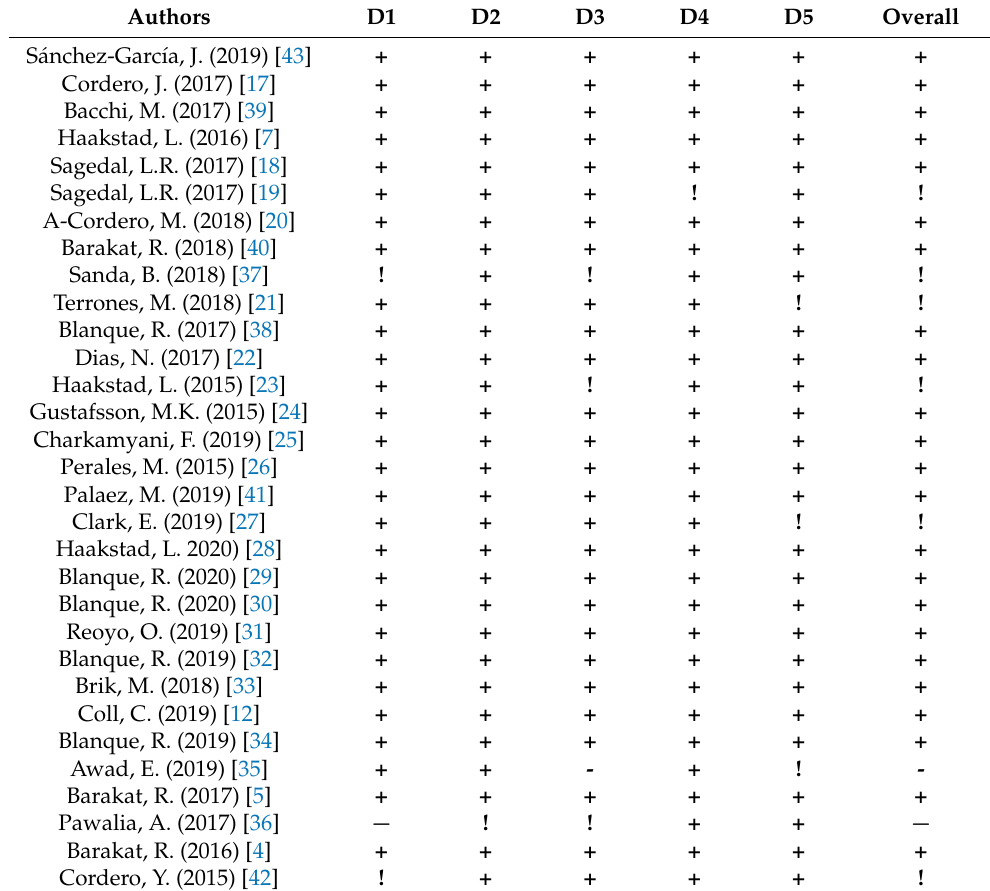
Table 1. Quality assessment and RoB2